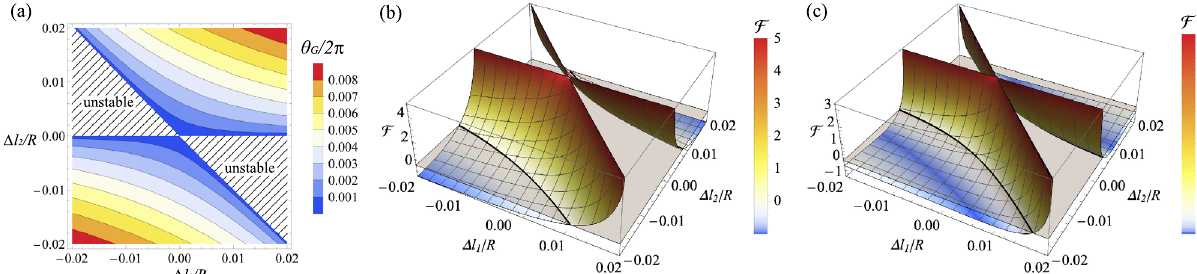
Figure 8. ( a ) Gouy phase shift ( θ G ) of the OPO with detunings (cid:31) l 1 and (cid:31) l 2 . Hatched areas show the unstable regions. ( b , c ) Enhancement factor F of using multimode squeezed light, defined in Eq. (48). When mode mismatch is 50% by ( b ) displacement or tilt and by ( c ) size difference, we compare the squeezing levels in a target mode by single-mode squeezed light (9.5 dB) and multimode squeezed light (9.5 dB at HG 00 and ξ 1 / 81 ). (cid:31) l 1 and (cid:31) l 2 are the detunings applied for cavity stability. F > 0 indicates that the multimode = squeezed light is better than the single-mode light. The area where the graph is not drawn corresponds to an unstable region of the OPO. For the plot, we use parameters of T i